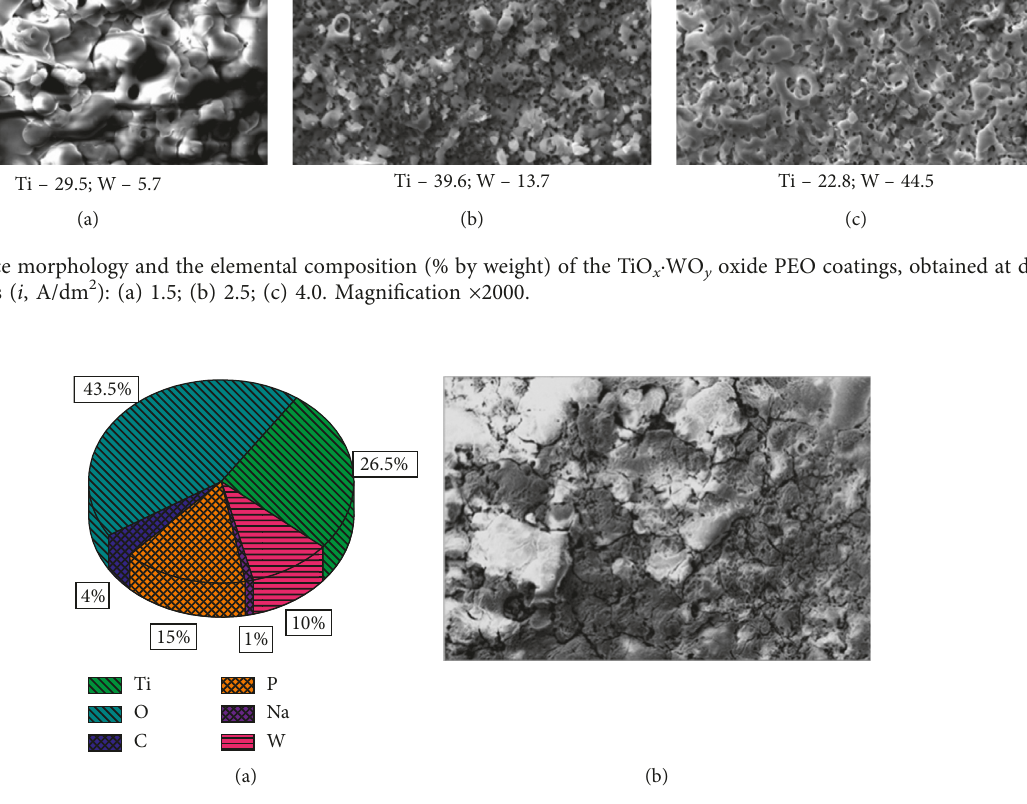
2 : (a) elemental composition, at.%; (b) surface morphology. Magnification Figure 6: Oxide coatings TiO x · WO y , obtained at i (cid:29) 5.0A/dm ×